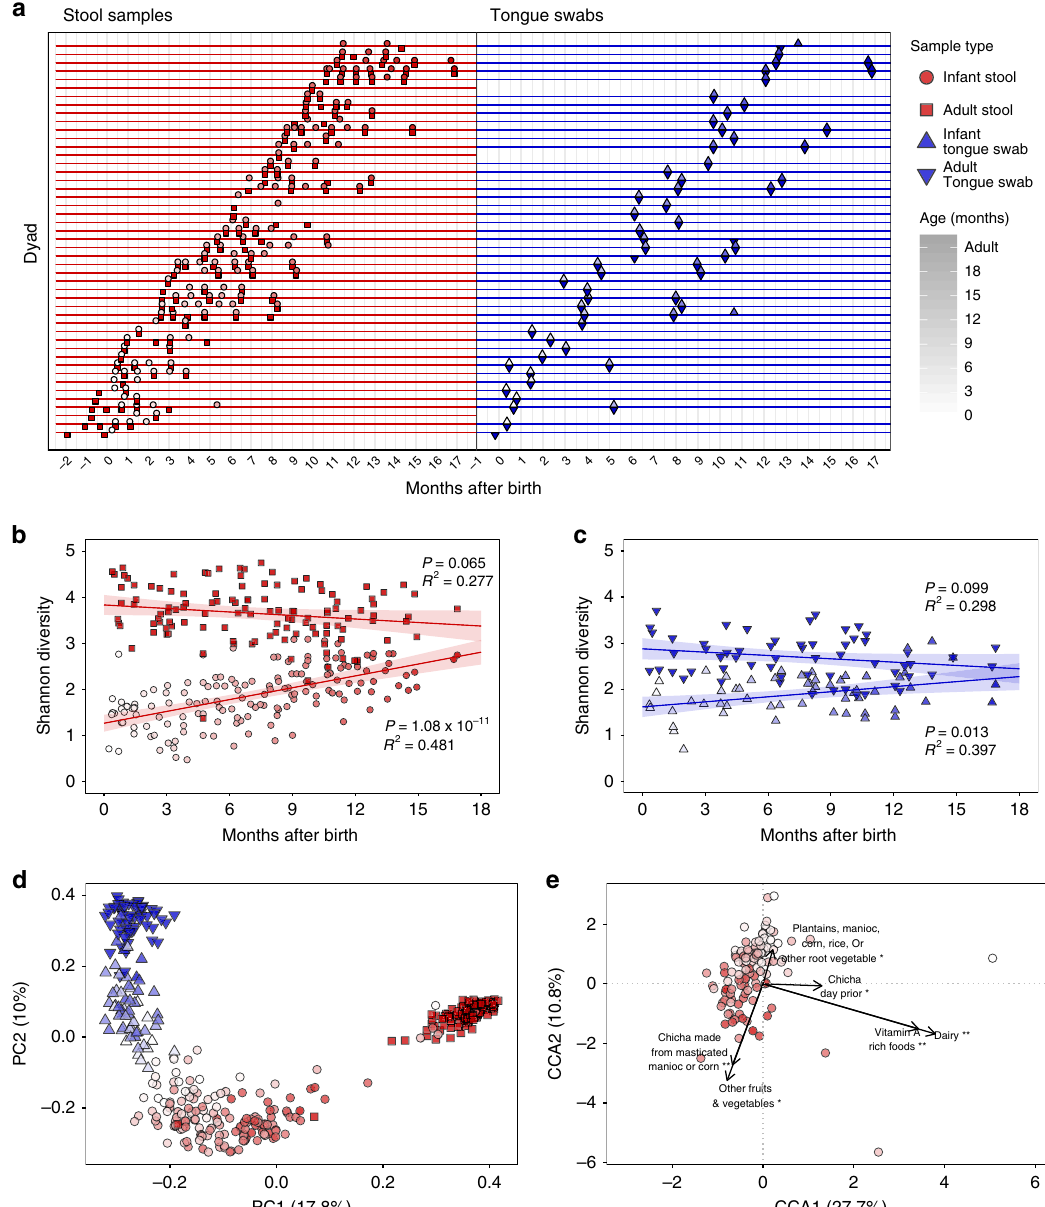
Fig. 1 Infant microbiota dynamics and dietary factors associated with maturation. a Timeline denoting fecal sample and tongue swab collections for each mother – child dyad relative to the infant ’ s birth date. For maternal samples, time refers to the immediate postpartum period. Infant stool samples are circles, adult stool samples are squares, infant and adult tongue swabs are triangles that point up or down, respectively. Shapes are colored by sample type (red = stool, blue = tongue swabs), and the color darkens as the subject ’ s age increases. Shapes and colors are consistent across a – e . b Shannon diversity index regressed against the time since the infant ’ s birth for stool samples (adult stool: P = .065, R 2 = 0.277; infant stool: P = 1.08 × 10 − 11 , R 2 = 0.481). Lines indicate the linear mixed-effects regression of diversity on time since delivery, while treating subject as a random effect. The shading indicates the 95% con fi dence interval. The conditional R 2 describes the proportion of variation explained by both the fi xed and random factors, and was calculated using the R package, “ piecewiseSEM ” . c Shannon diversity index regressed against the time since the infant ’ s birth for tongue swab samples (adult tongue swabs: P = .099, R 2 = 0.298; infant tongue swabs: P = .013, R 2 = 0.397). Figure details are the same as in ( b ). d Principal coordinate analysis (PCoA) using a distance matrix calculated using the Jaccard similarity index of microbiota taxa composition in stool samples and tongue swabs from Tsimane dyads. e A partial canonical correspondence analysis (CCA) of ASV abundances, constrained against a matrix of diet survey data. The effects of infant age and village were controlled using a conditioning matrix. Signi fi cance was assessed using an ANOVA-like permutation test with 1000 permutations. Source data are provided in the Source Data fi (Fig. 1d), those communities were not more similar to those of their mothers than they were to those of unrelated adults (Supplementary Fig. 3), in contrast to the stool communities. This supports the fi ndings of a previous cross-sectional study showing